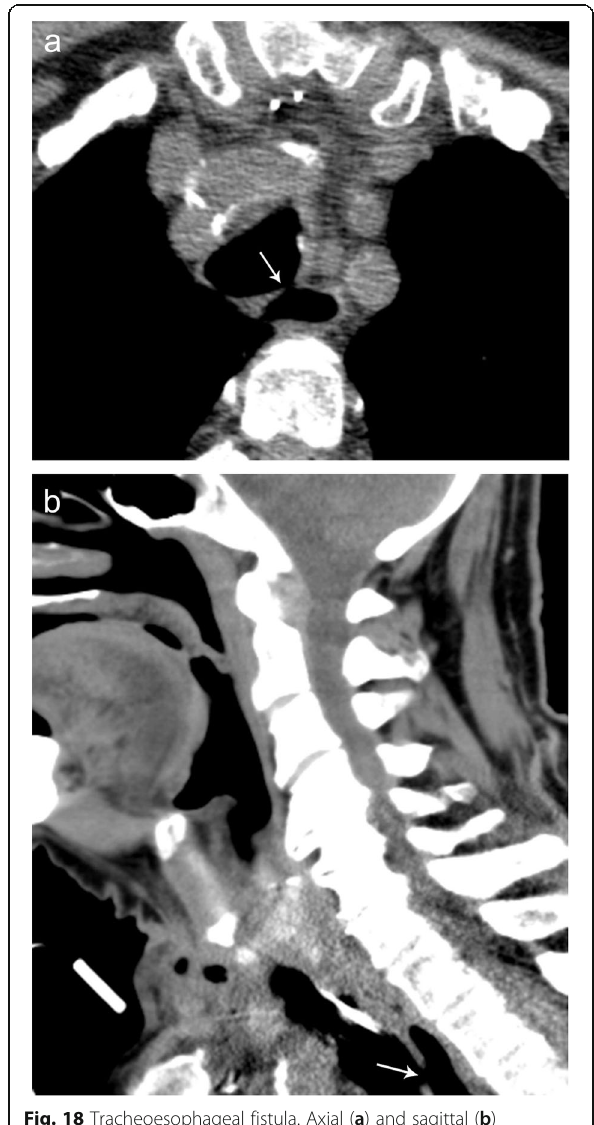
Fig. 18 Tracheoesophageal fistula. Axial ( a ) and sagittal ( b ) noncontrast CT images demonstrating a communication (arrow) between the trachea and esophagus consistent with a tracheoesophageal fistula as a complication of esophageal stent placement in a patient with a history of esophageal